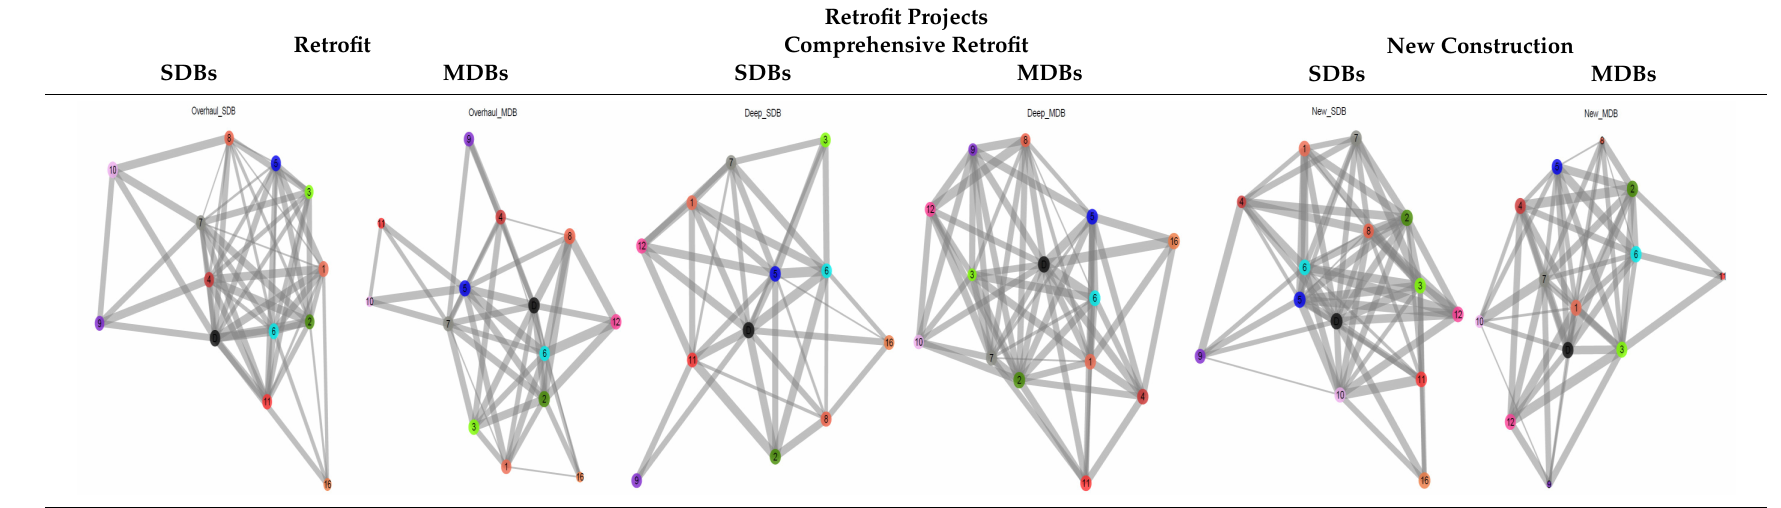
Table 11. Stakeholder level of power and interaction in the technology selection, classified according to building typologies and project types in the Netherlands